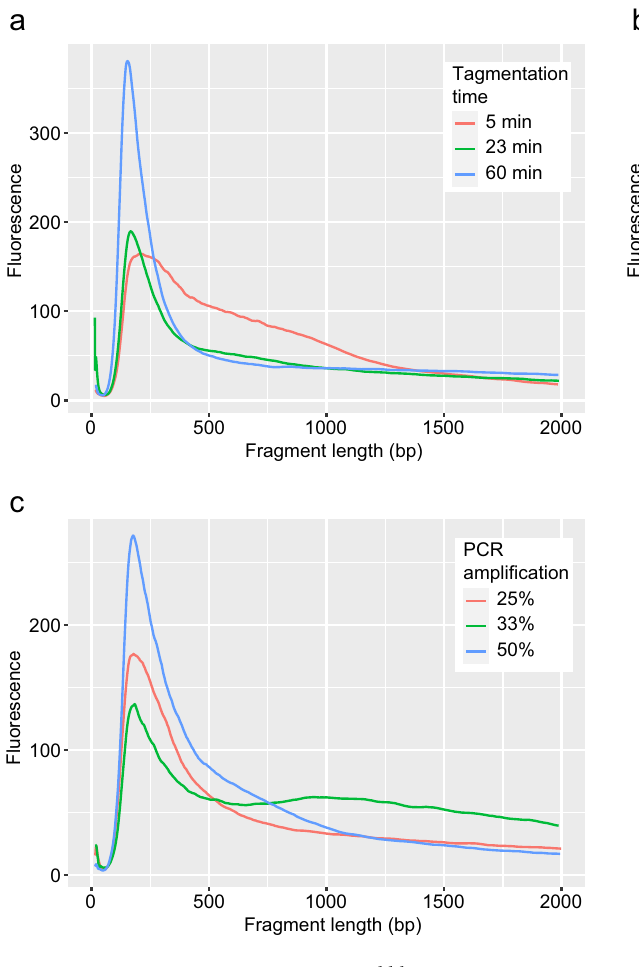
Figure 5. Optimal library construction parameters. Nuclear GFP expression was driven using various genotypes. Isolated nuclei were used in ATAC-seq library construction. The fragment sizes and relative fluorescence from Tapestation data are shown. ( a ) Tn5 reaction time; ( b ) Tn5 concentration; and ( c ) post-Tn5 PCR amplification. GFP expression was driven using ( a , c ) nSyb-Gal4 UAS-GFP-nls or ( b ) tubulin-Gal4 UAS-